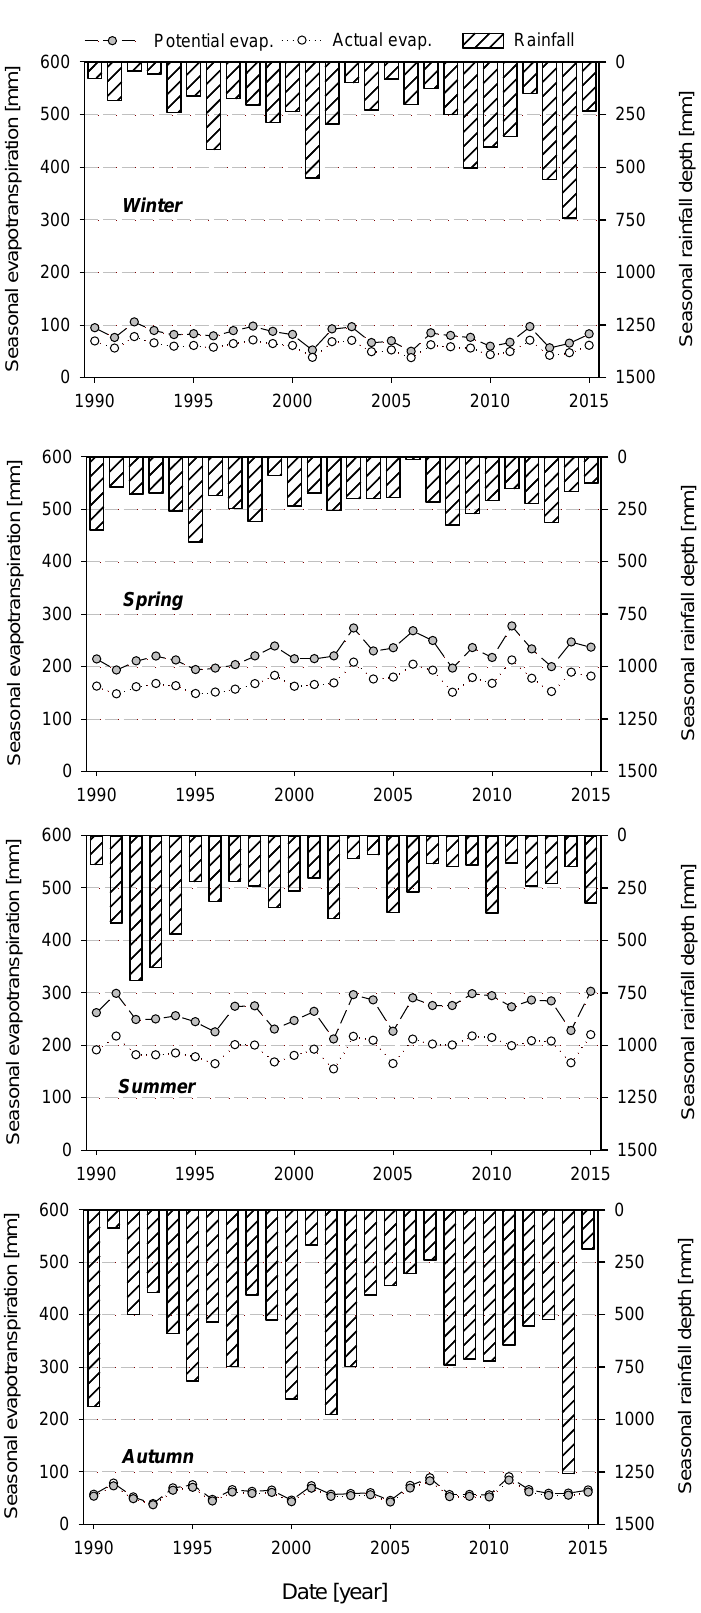
Figure 2. Seasonal evapotranspiration and rainfall depth for the time series climate records (1990–2015) of Villa Cambiaso (Genoa, Italy). The grey dots indicate the potential evapotranspiration and the white dots the actual